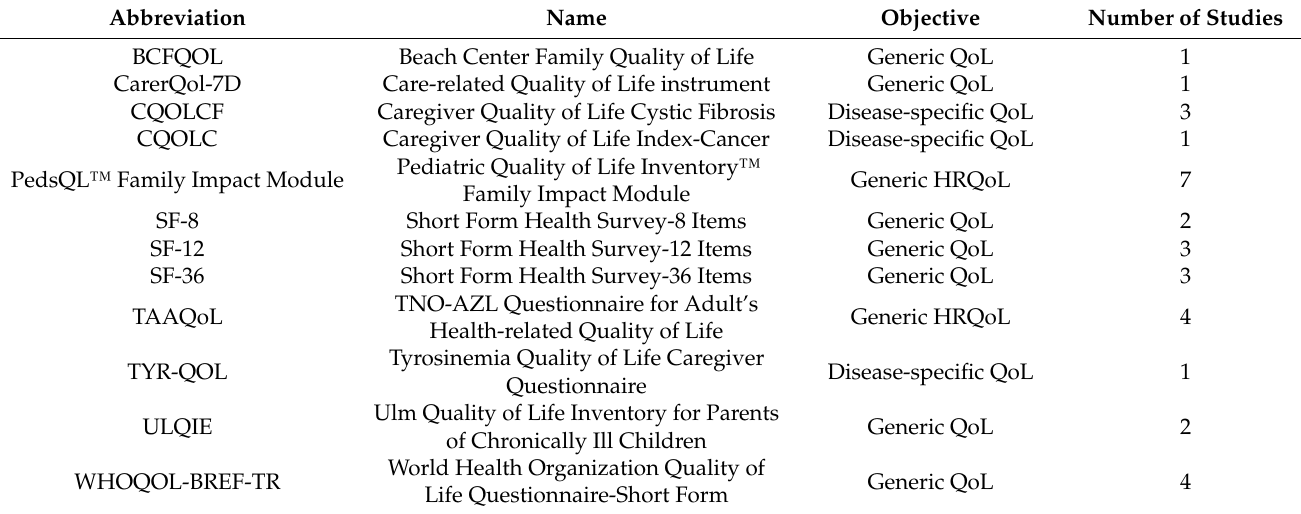
Table 3. List of quality of life